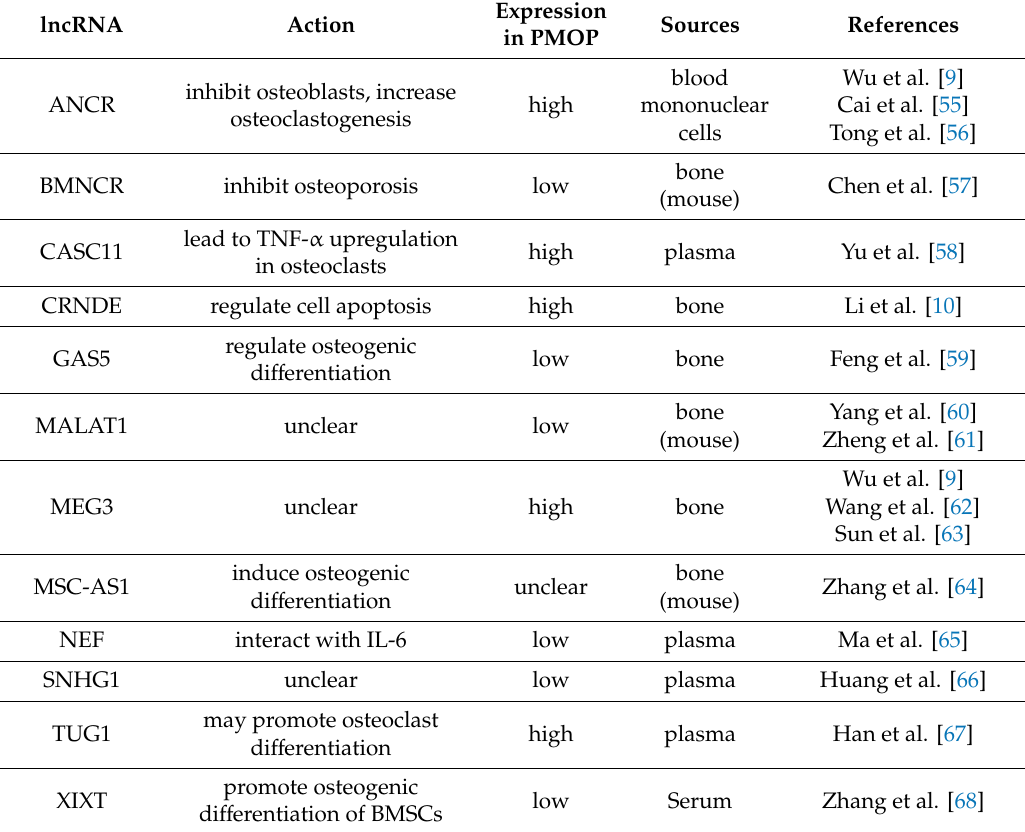
Table 2. List of long-non-coding RNAs (lncRNAs), their actions, and expression in PMOP. Studies were performed in humans unless otherwise stated in